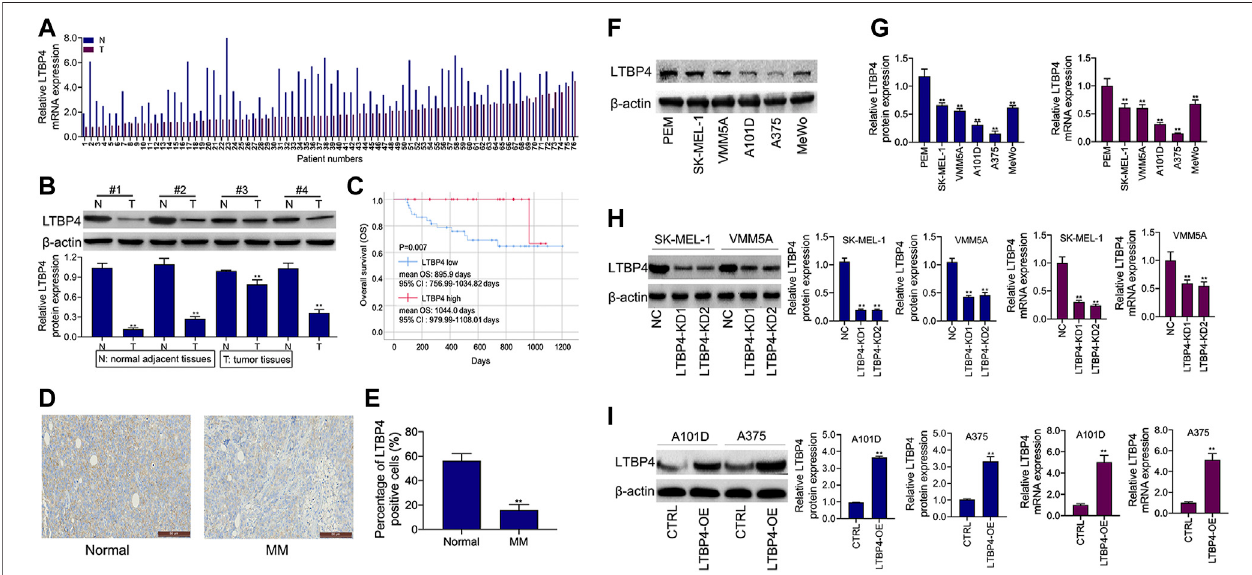
FIGURE 2 | LTBP4 expression was down-regulation in melanoma tissues and cell lines, which was closely related to the poor survival for patients with melanoma. (A) ThemRNAlevelofLTBP4inmelanomatissueswasdetectedbyRT-PCRassay. (B) TheproteinlevelofLTBP4inmelanomatissueswasdetectedbywesternblotting assay. (C) Survival curve was performed by using the Kaplan-Meier method, and differences between the curves in LTBP4 high expression group and LTBP4 low expression group were determined by log-rank test (D and E) LTBP4 expression in melanoma tissues was determined by IHC staining. (F) The protein level of LTBP4inmelanomacelllineswasdetectedbywesternblottingassay. (G) ThemRNAlevelofLTBP4inmelanomacelllineswasdetectedbyRT-PCRassay. (H) shRNA- LTBP4#1 or #2 was transfected into SK-MEL-1 and VMM5A cells, the protein and mRNA levels of LTBP4 were detected by western blotting and RT-PCR assays. (I) LTBP4expressingplasmidsweretransfectedintoA101DandA375cells,theproteinandmRNAlevelsofLTBP4weredetectedbywesternblottingandRT-PCRassays. β -actin was used as a load control. Data are presented as the mean ± standard deviation. ** p < 0.01 vs NC/normal/HaCaT group.